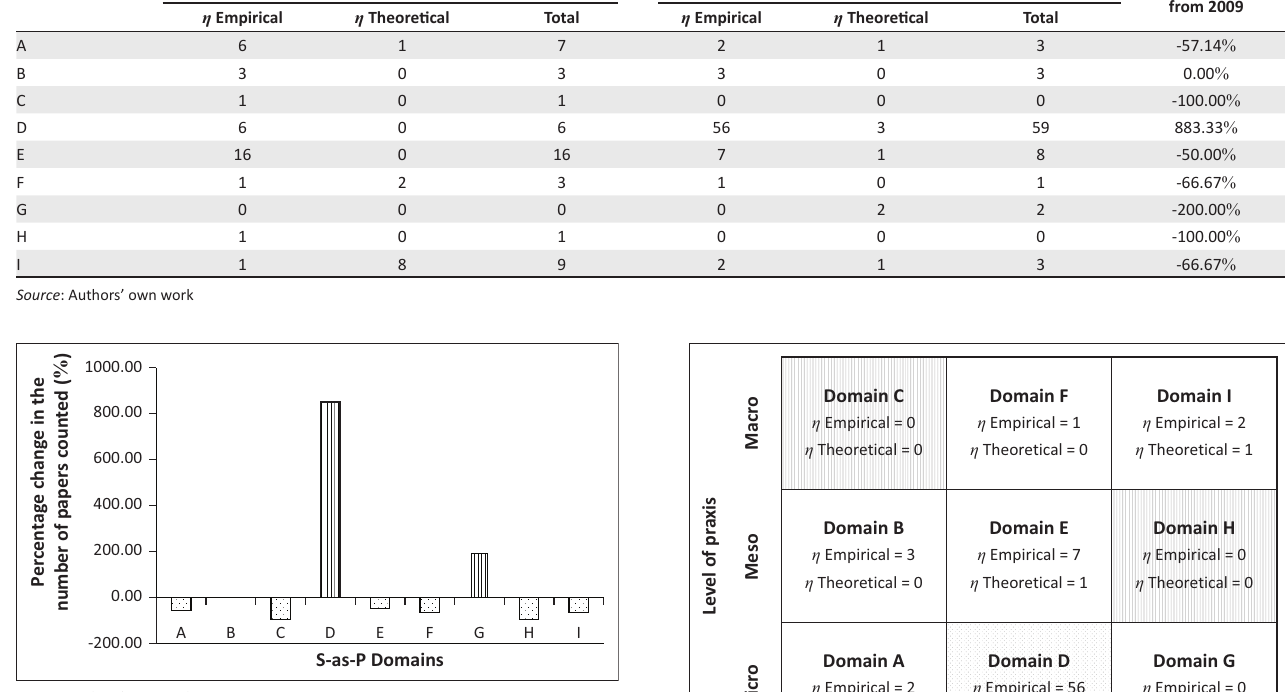
TABLE 3: The number of papers counted in each strategy–as–practice (S-as-P) domain. Domains